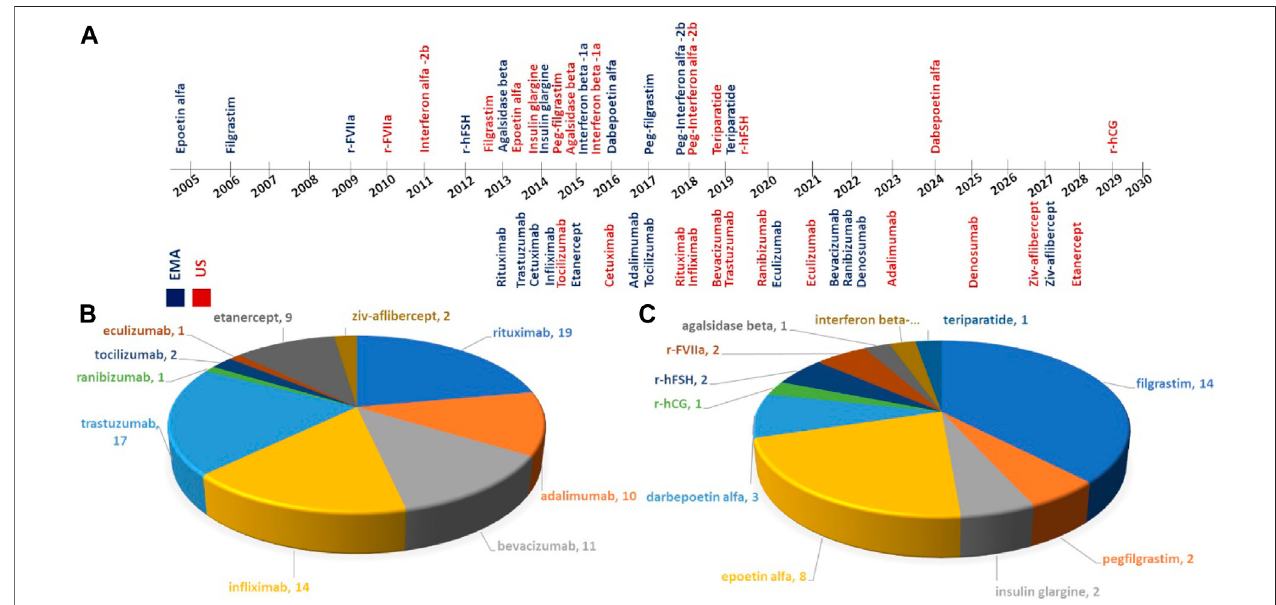
FIGURE 3 | (A) Timeline on patent expirations of reference products in European Medicines Agency; EMA (Moorkens et al., 2020) and U.S. Food and Drug Administration; USFDA (Derbyshire and Shina, 2019), publications on analytical similarity studies for biosimilars under (B) mAbs, and (C)